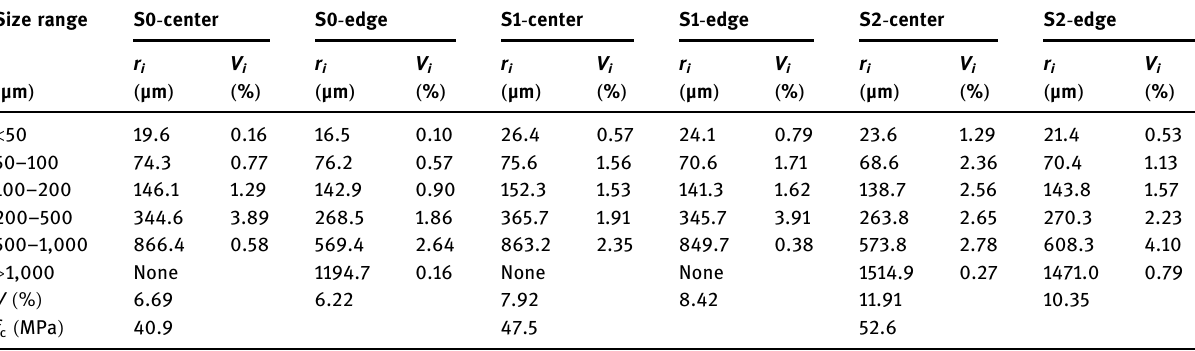
Table 4: Parameters for quantitative